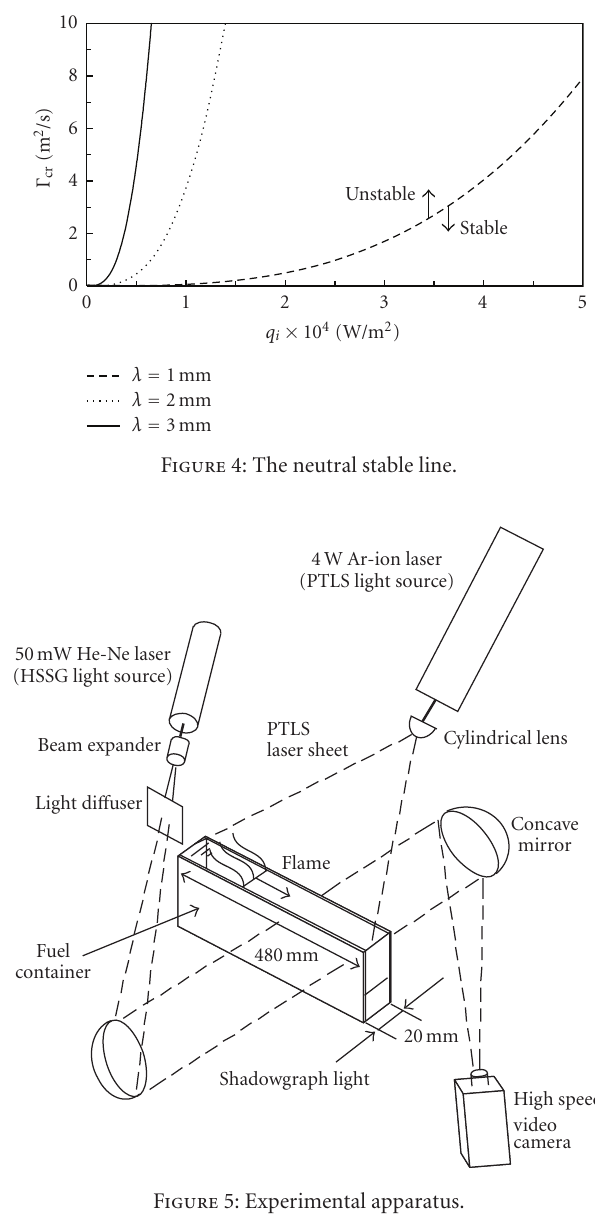
Figure 5: Experimental